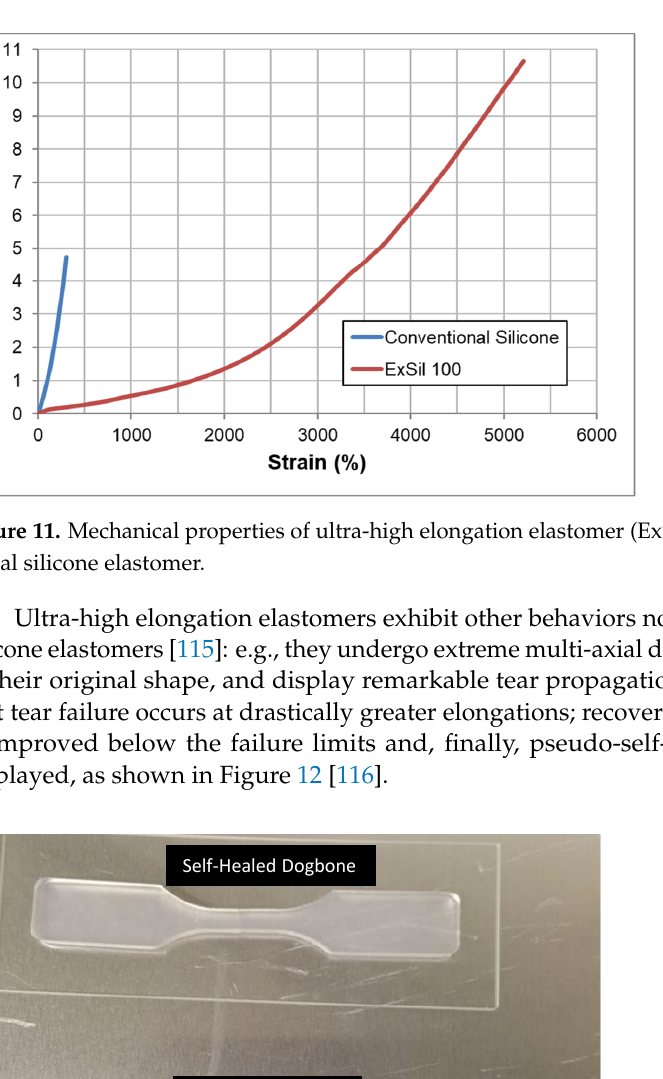
Figure 10. Atomistic model of a 50,000 Da segment of ultra-high elongation elastomer suggesting 1–2 knots. (Author’s work).